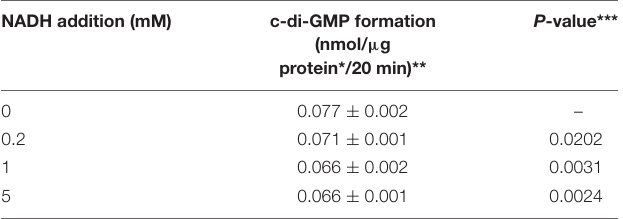
TABLE 4 | Effect of NADH on the activity of diguanylate